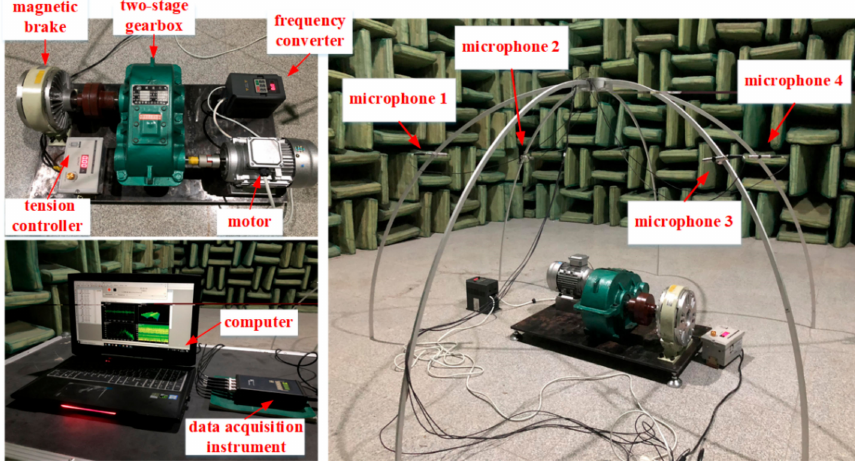
Figure 5. Experimental system in a semi-anechoic chamber.